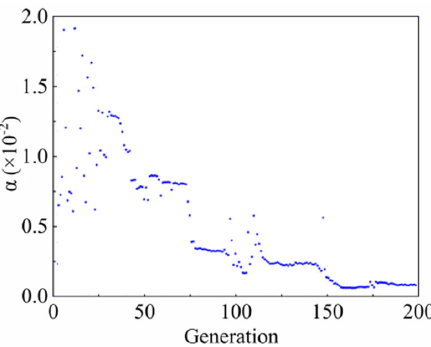
Figure 11. The variation in convergence factor with the evolution generation.